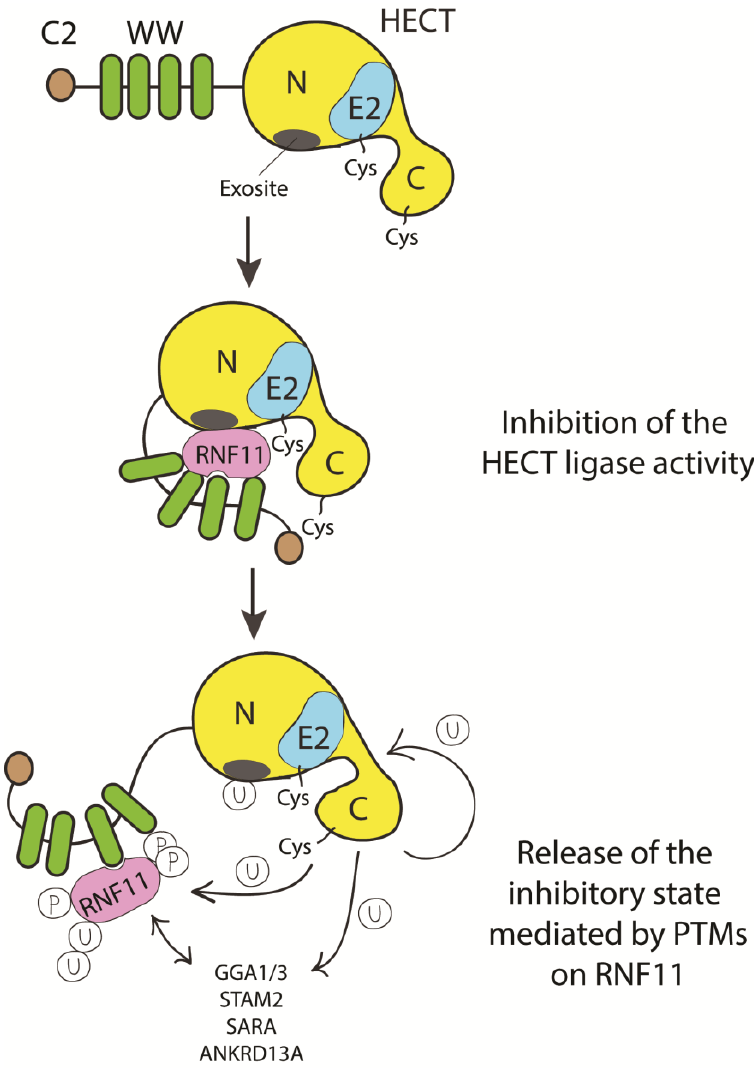
Figure 5. Cartoon representing putative inhibitory mechanisms of HECT ligases mediated by RNF11. E3-ligases of the HECT family are characterized by the presence of C2 and WW domains located upstream of the catalytic domain. RNF11 binds the WW domain containing region of all the HECT family members and these interactions are reported to inhibit HECT activity. This inhibition can result from several events. Here, we suggest that RNF11 promotes a closed conformation, which masks the E2-binding site and/or the non-covalent ubiquitin binding site (exosite) on the HECT ligase. Post-translational modifications modulated by the activation of different signaling pathways could be responsible for the conformational modifications of RNF11, allowing the recruitment of substrates on the WW domains and triggering the adaptor functions of